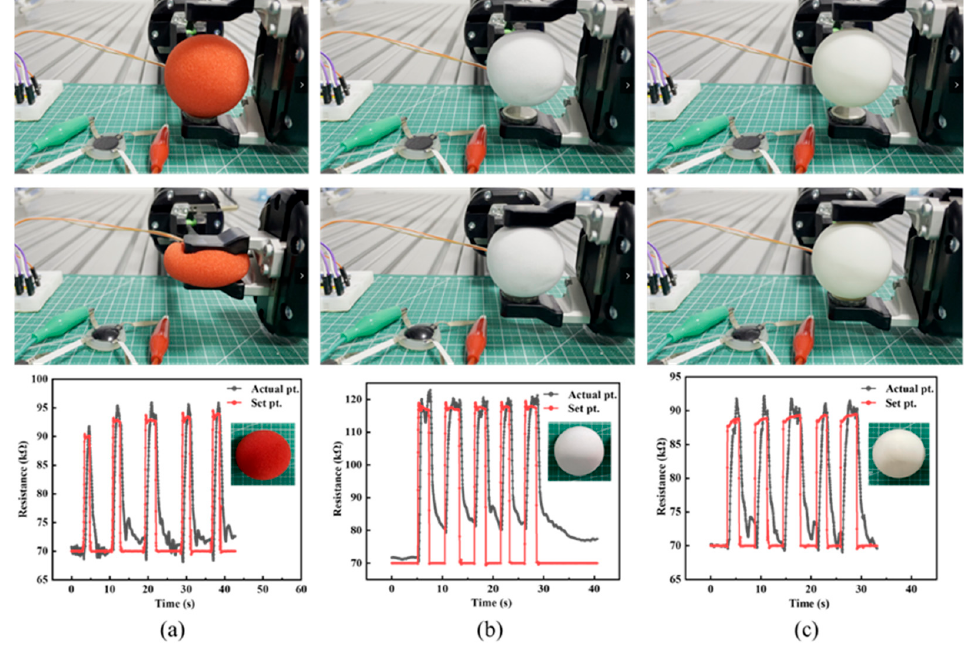
Figure 15. The response of SEHPA when balls with different hardness of ( a ) sponge ball, ( b ) foam ball, and ( c ) table tennis were clamped by a mechanical gripper.